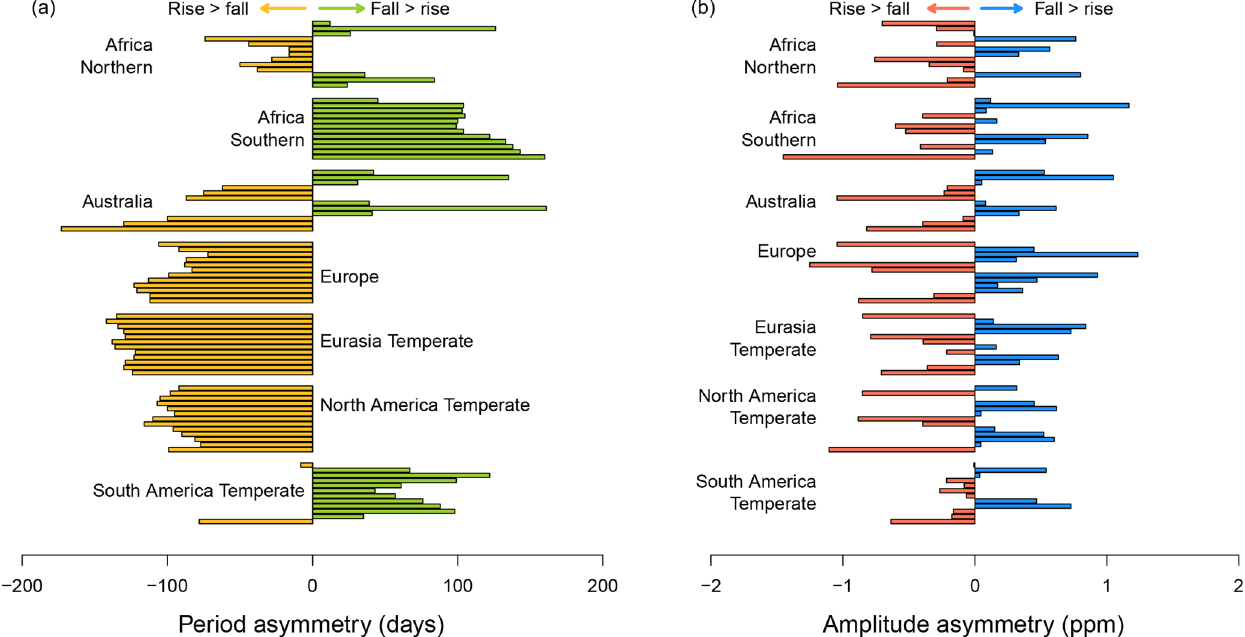
Figure 6. Period asymmetries (a) and amplitude asymmetries (b) in GOSAT XCO 2 seasonal cycles. The bars represent differences in amplitude or period for consecutive fall (F) and rise (R) segments, taking the fall segment as reference. For example, if the time series follows the sequence F1, R1, F2, R2, F3, R3 (i.e., three seasonal cycles), then the difference between the first segment (F1) and the second segment (R2) is calculated as “F1–R2”; a zero value would indicate that the metrics (amplitude or period) were equal, whereas an asymmetry would be indicated by a positive (F1 > R2) or negative (F1 < R2) value. By definition, consecutive segments cannot be categorized as F–F or R–R. Asymmetry statistics are not traditional summaries, but, nevertheless, they are characteristic and, in some regions, persistent patterns of the seasonal cycle that are undoubtedly influenced by biosphere